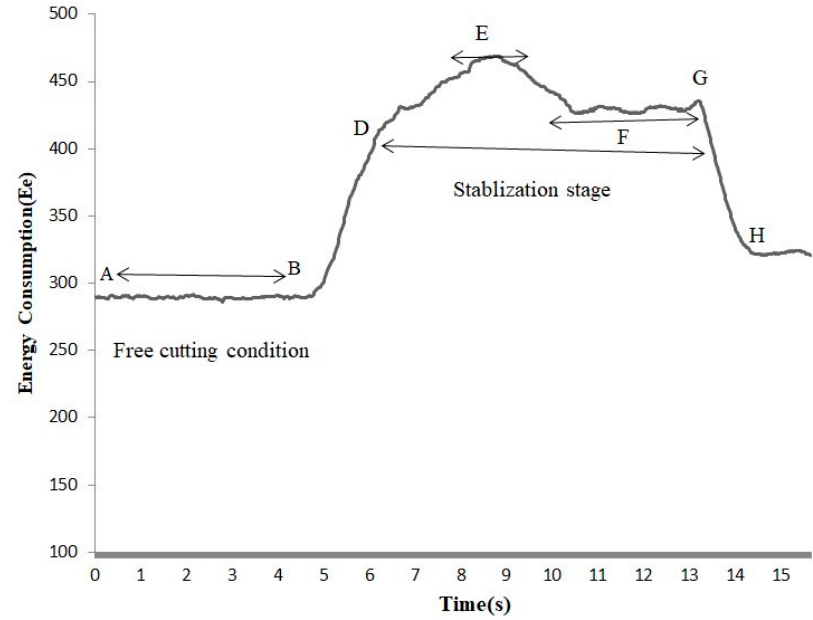
Figure 7. Energy consumption behavior during cutting with disc.